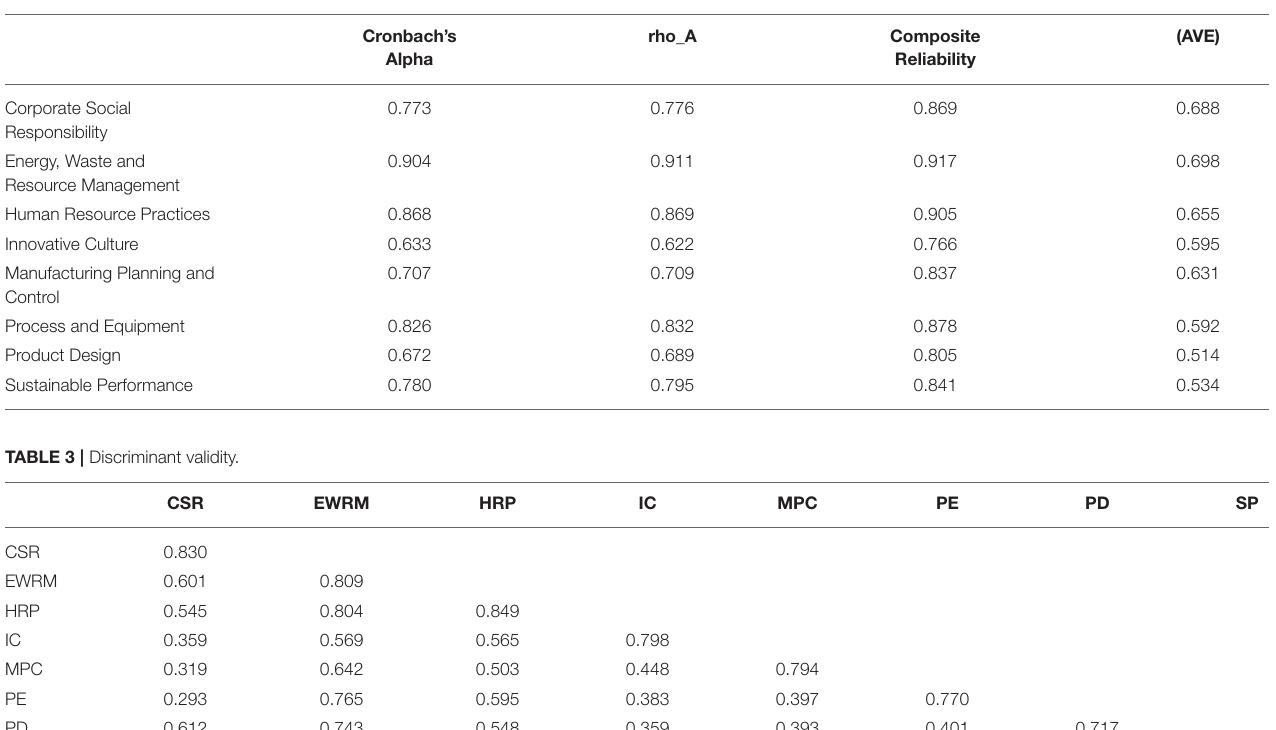
TABLE 2 | Factor loadings, reliabilities, and AVE.